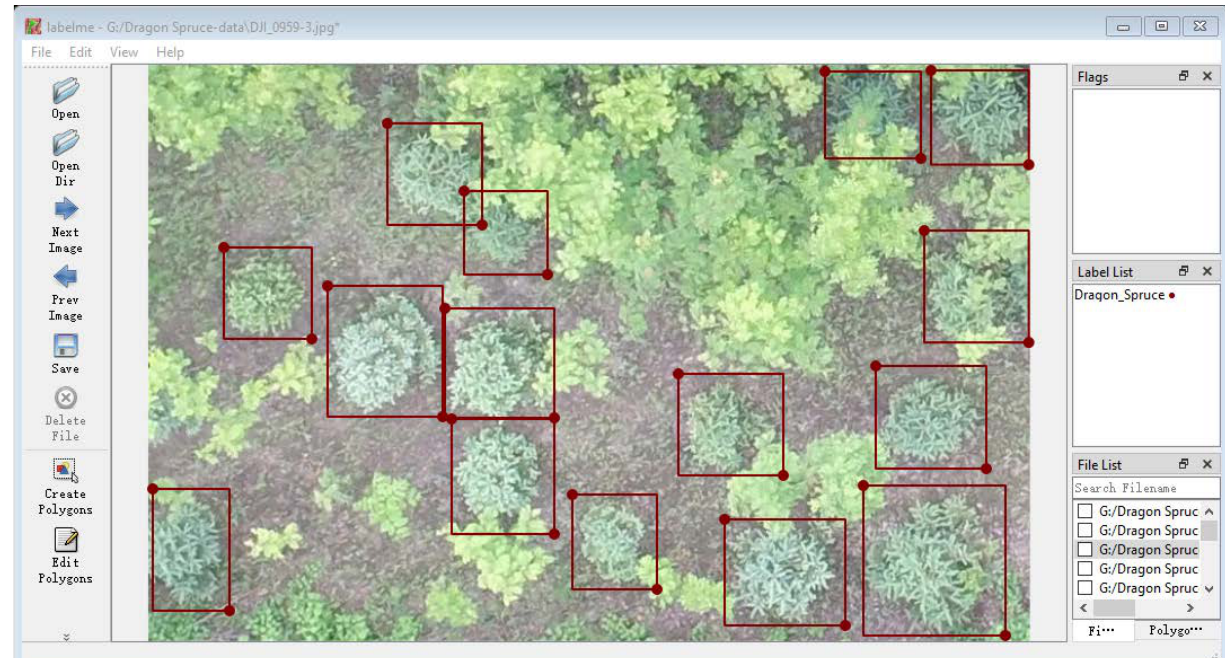
Figure 2. The manual annotation of the seedlings using the ‘LabelImg’ tool.